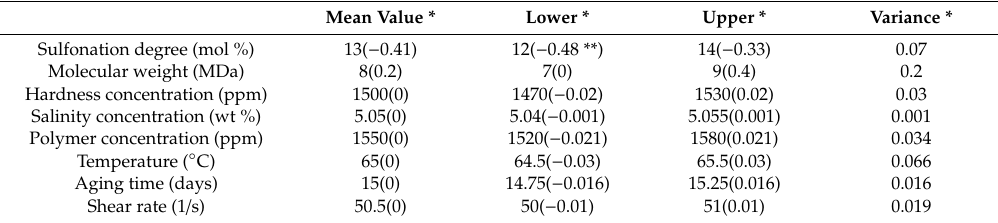
Table 5. Values of the input parameter and associated uncertainties derived from measurements number 28 from Table S1 in Supplementary File A.